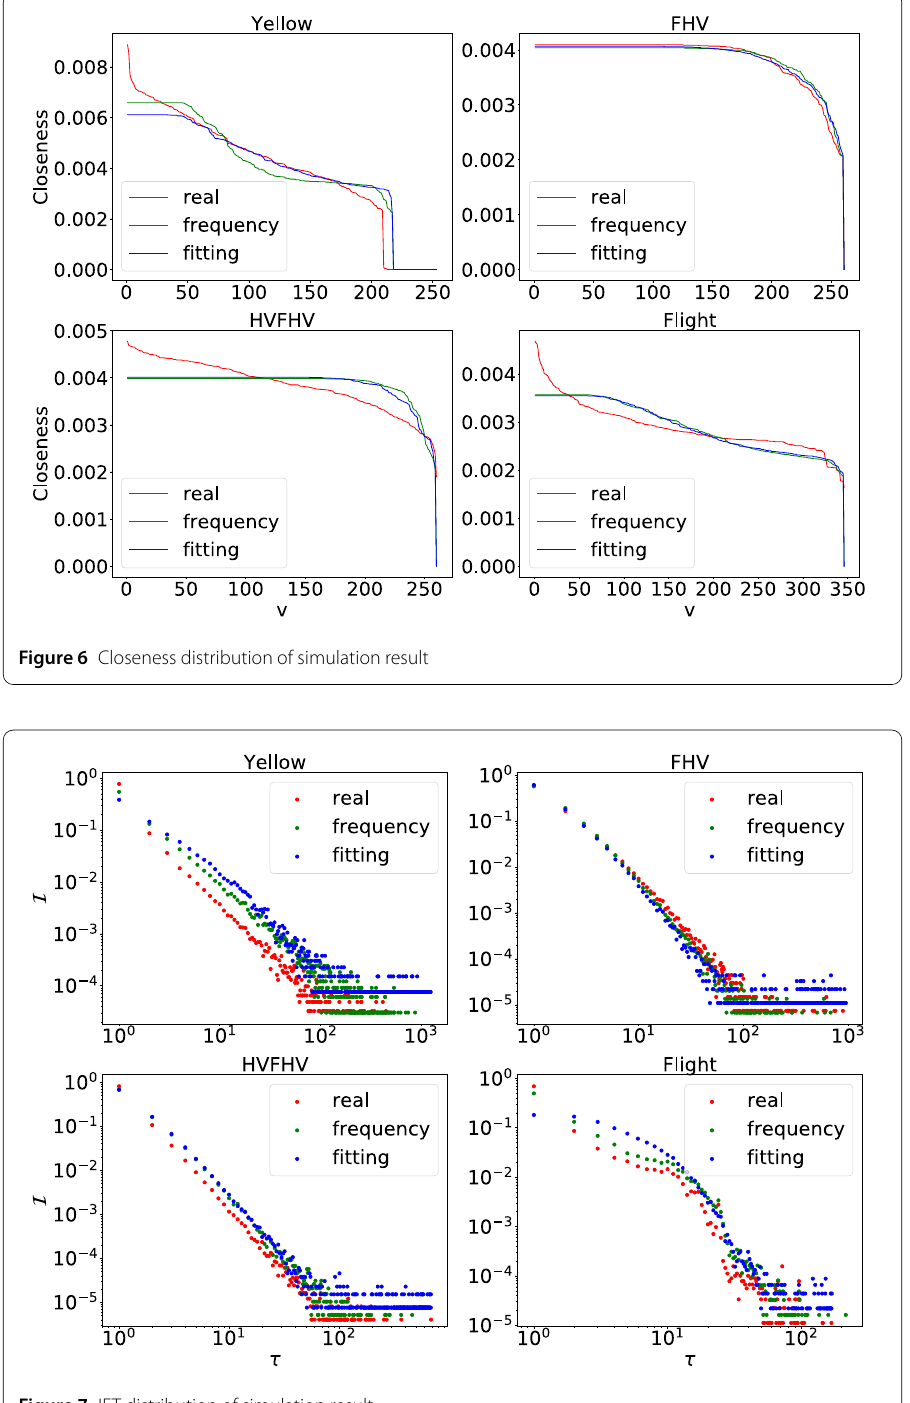
Figure 7 IET distribution of simulation